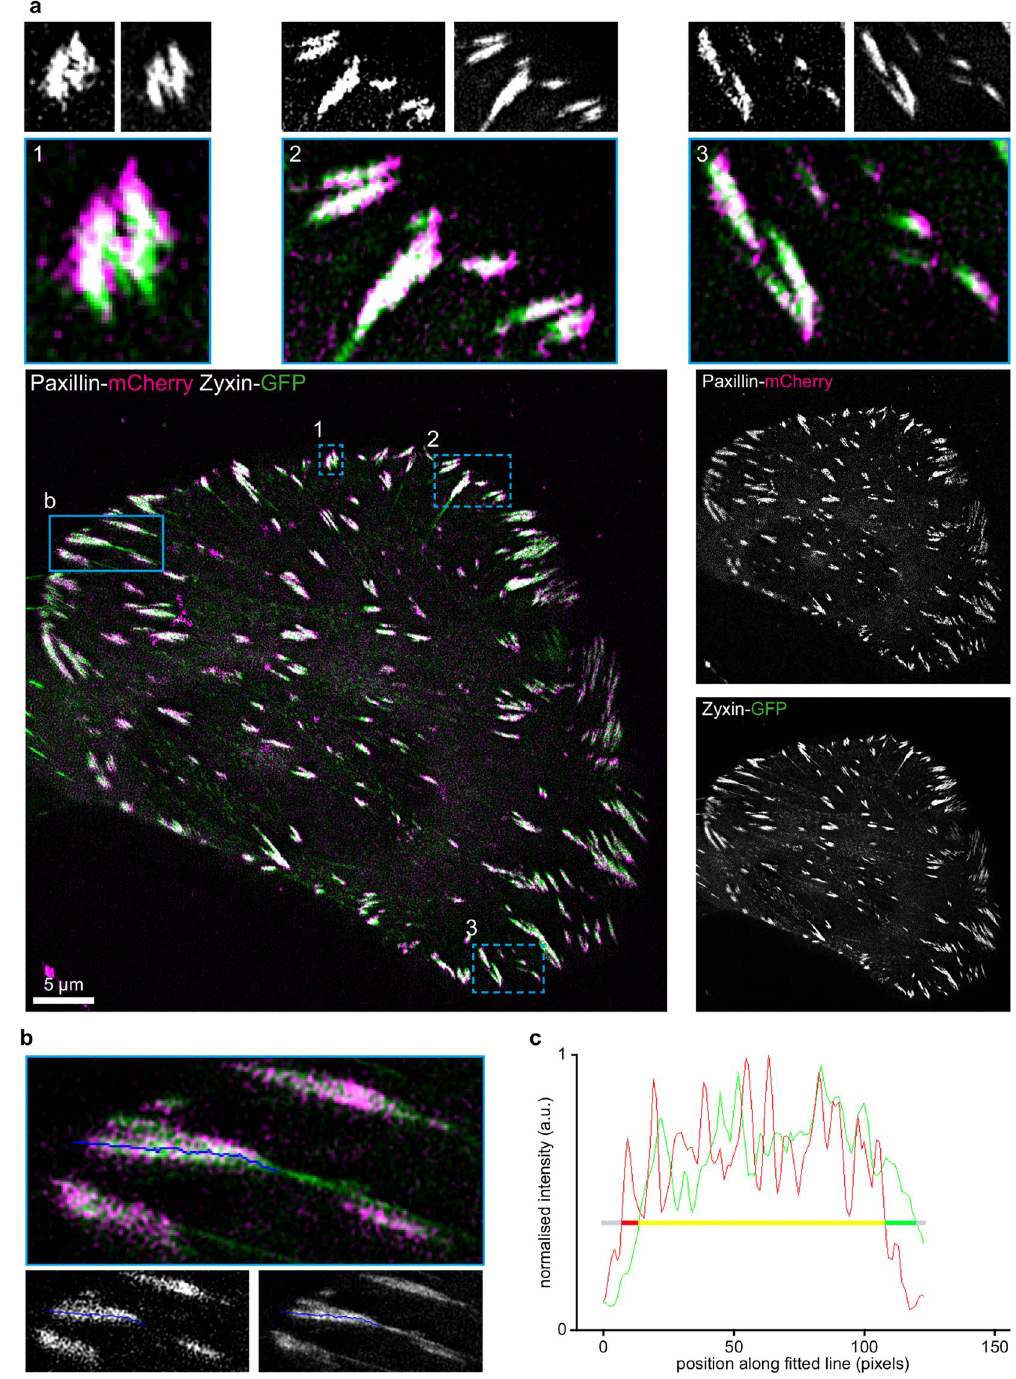
Figure 1. Measuring FA head and tail lengths using structured illumination microscopy. ( a ) Representative SIM image of a U2OS cell co-expressing C-terminally tagged paxillin-mCherry and zyxin-GFP. The bottom row shows the merged image on the left (red channel pseudocoloured magenta) and greyscale images of the indicated separate channels are provided on the right. The three numbered panels in the top row are magnifications of the corresponding blue dashed boxed areas and the greyscale images on top show the red (left) and green (right) channels separately. Contrast is enhanced for visualisation purposes, note that data analysis is always performed on images with original contrast settings. ( b ) Magnification of the indicated blue boxed area in a of the merged (top), red (bottom, left) and green (bottom, right) channels. The blue line was automatically fit to the longitudinal axis of the FA (see Materials and Methods). ( c ) Intensity profiles of the red and the green channels as measured along the line indicated in b, normalised to maximum values. The horizontal line indicates the threshold (40% of maximum intensity, see Materials and Methods). Yellow indicates that both signals are above threshold; red indicates that only the red channel is above threshold; green indicates only the green channel above threshold; grey indicates both channels are below